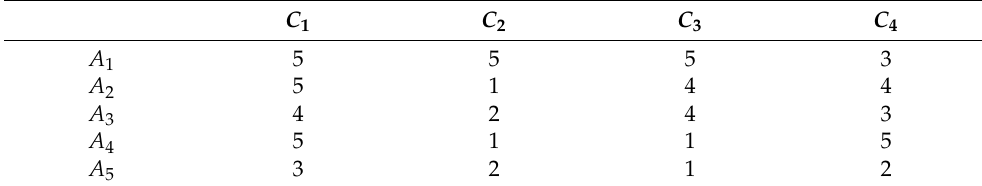
Table 6. The fourth of four selected initial decision-making matrices.